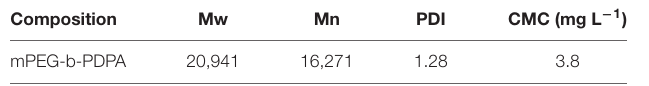
TABLE 1 | Molecular weight results of mPEG-b-PDPA polymer based on GPC.